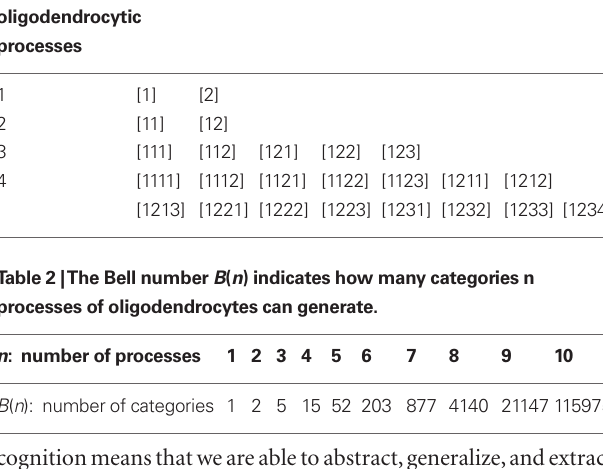
Table 1 | Qualitative counting in categories ( n = 4) shown on an oligodendrocyte-axonic system.